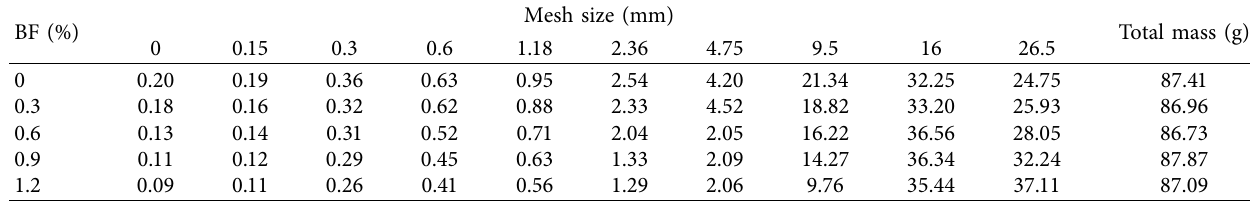
Figure 17: Failure patterns of basalt fiber-reinforced cement-fly ash-stabilized soil in SHPB tests. (a) BF � 0%. (b) BF � 0.3%. (c) BF � 0.6%. (d) BF � 0.9%. (e) BF � 1.2%. Table 3: Sieving test results of impact fragments of basalt fiber-reinforced cement-fly ash-stabilized soil (0.3MPa impact loading pressure).